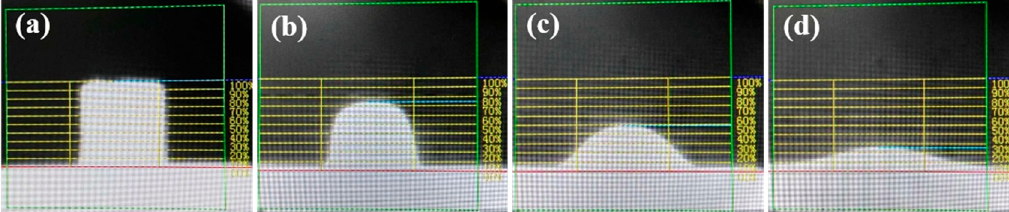
Figure 2. The height changes of slag melting process. ( a ) The original height; ( b ) The corresponding height of softening temperature; ( c ) The corresponding height of hemispheric temperature; ( d ) The corresponding height of flow